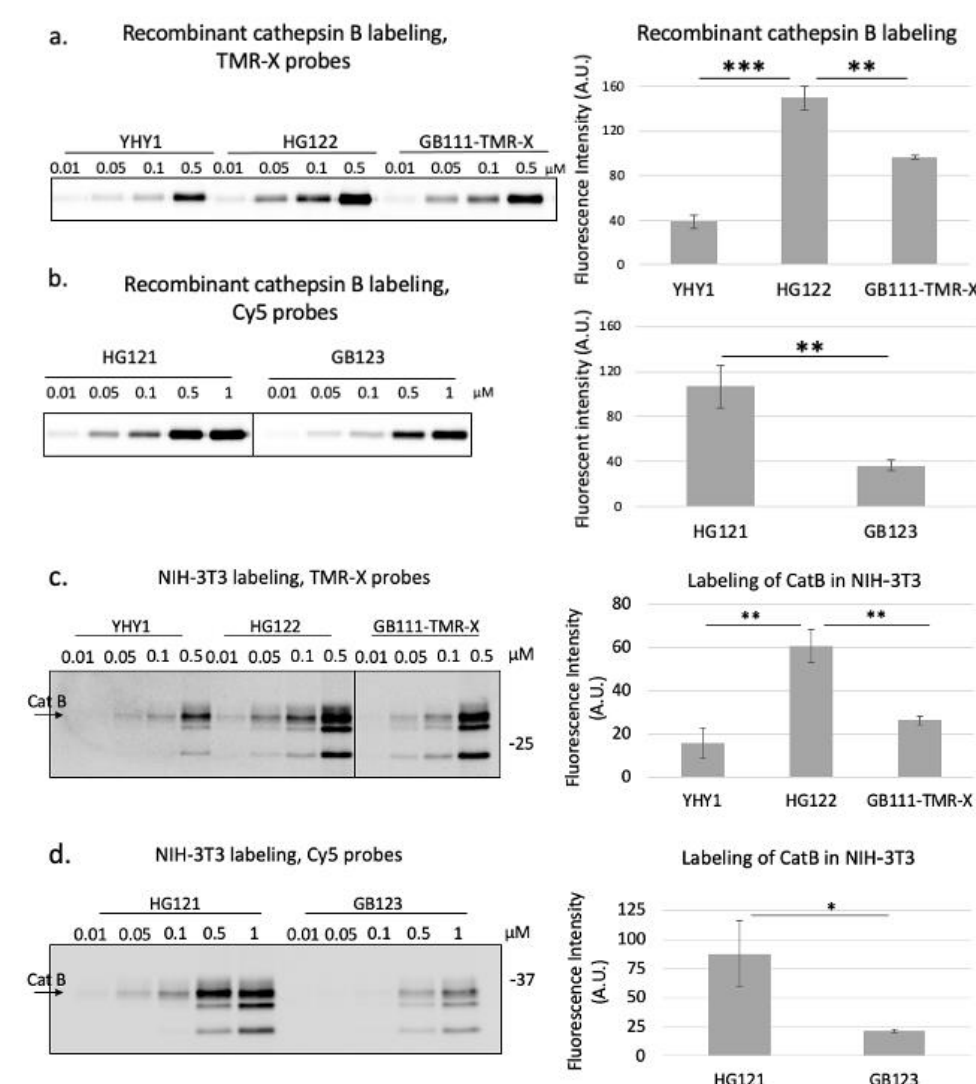
Figure 3. Labeling recombinant cathepsin B and endogenous cathepsin activity in intact NIH-3T3 cell. Labeling of recombinant cathepsin B as described in Figure 1 seen in ( a ). Quantification of the band intensity of 0.1 µM probe (of 3 technical repeats) is presented on the right; TMR-X labeled probes were scanned at 532/570 nm. Cy5 labeled probes, scanned at 630/670 nm, ( b ). Monolayers of NIH-3T3 cells were treated with indicated probes for 24 h at 37 °C and then lysed with RIPA buffer. Equal protein amounts were resolved by SDS PAGE that was scanned with a Typhoon scanner. Scans for TMR-X in ( c ) and of Cy5 in ( d ). Cathepsin B band is marked by an arrow. Bars represent mean ± SD, * p ≤ 0.05, ** p ≤ 0.01, *** p ≤ 0.0001 . Samples in each panel were cropped from the same gel.